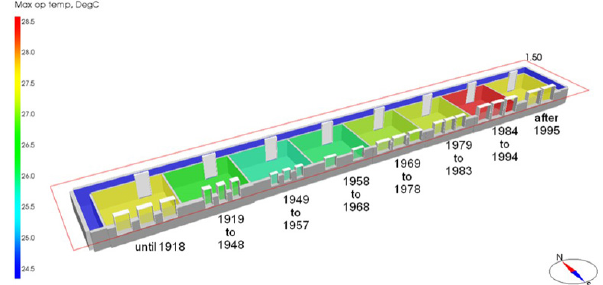
Figure 3. Maximum operative temperature depending on age and structure of